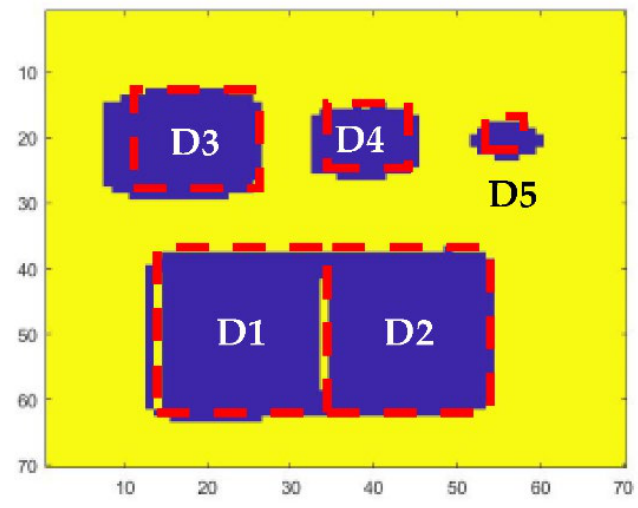
Figure 13. Spatial image using a k-medoids clustering algorithm.